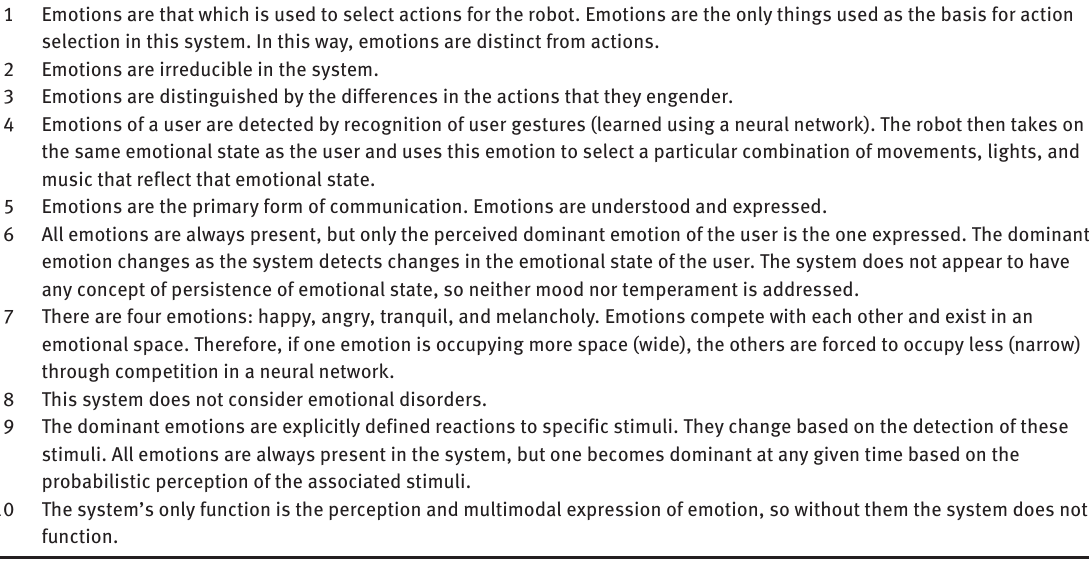
Table 12. Classification of Emotion and KANSEI [24].